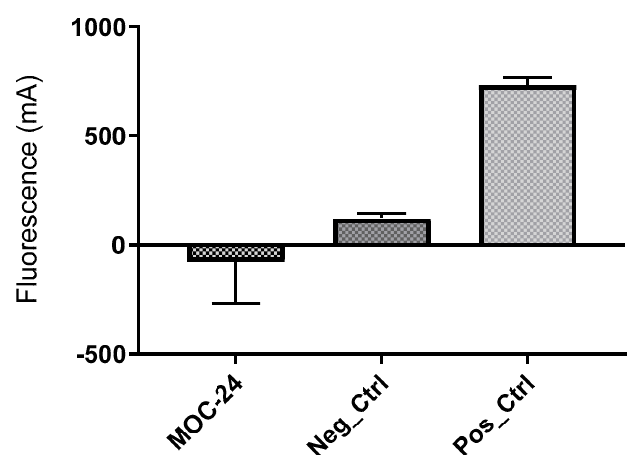
Figure 5. The e ff ect of MOC-24 on the NS3 activity ( n = 5). Neg_Ctrl = NS3 alone, MOC-24 = NS3 Figure 5. The effect of MOC-24 on the NS3 activity ( n = 5). Neg_Ctrl = NS3 alone, MOC-24 = NS3 mixed with MOC-24 and Pos_Ctrl = NS3 mixed with NS4A 21‘–33‘ . The emitted fluorescence (Y axis) are mixed with MOC-24 and Pos_Ctrl = NS3 mixed with NS4A 21` – 33` . The emitted fluorescence (Y axis) are proportional to the catalytic activity of the enzyme ( n = proportional to the catalytic activity of the enzyme ( n = 3).